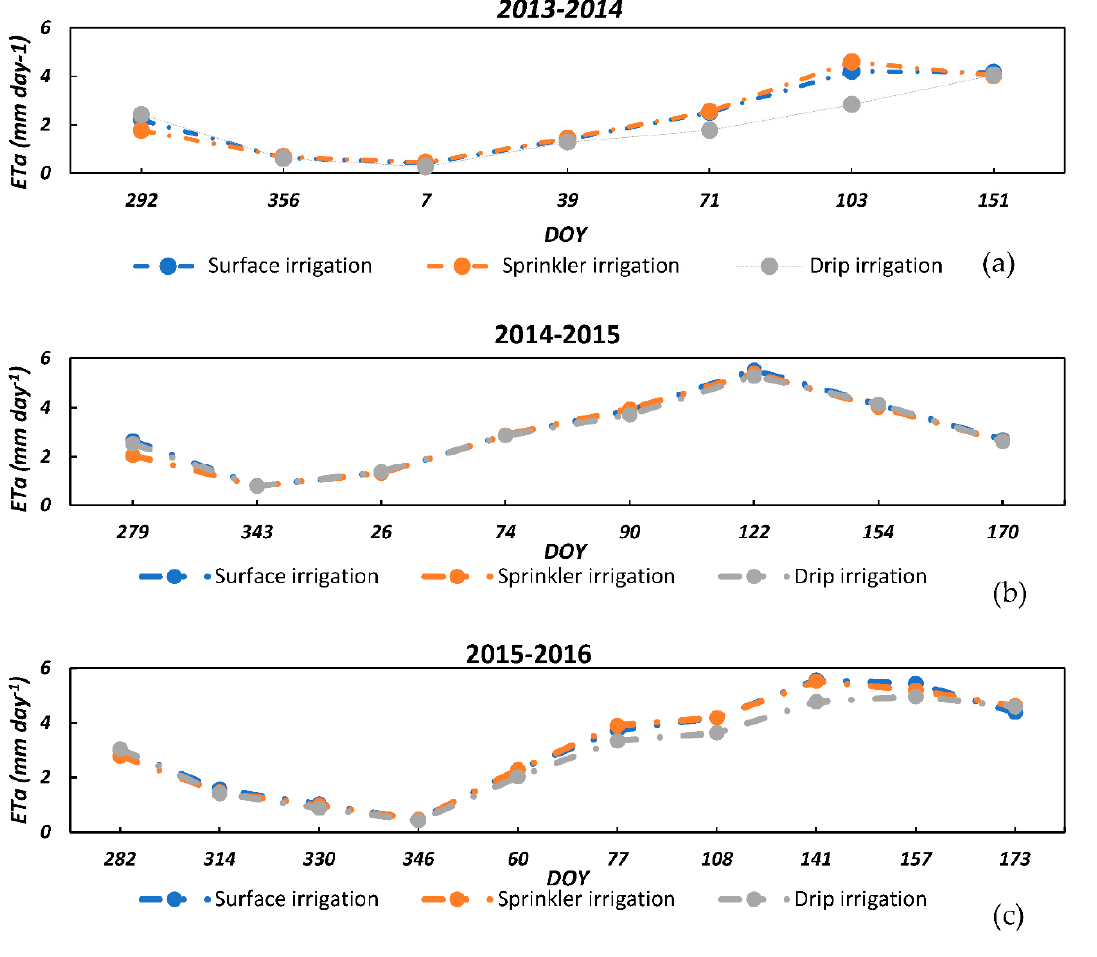
Figure 9. Doukkala irrigation scheme: actual daily evapotranspiration ET a estimated by applying SEBAL to multispectral L8 / OLI, TIRS image data and averaged over areas dominated by surface, sprinkler and drip irrigation in the: ( a ) reference year 2013–2014, ( b ) wet year 2014–2015, and ( c ) dry year 2015–2016.